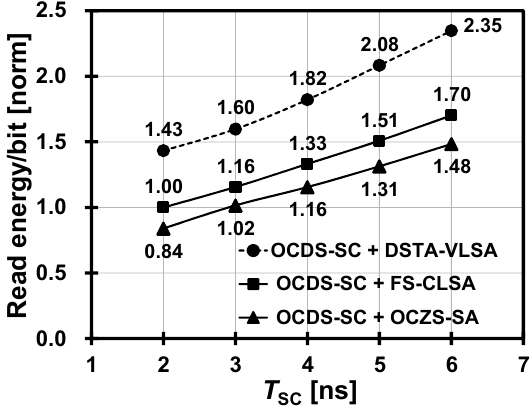
Figure 12. Minimum I read of the OCDS-SC that satisfies a target RAPY CELL of 6 σ according to T SC at σ SA_OS values of 33.8 mV, 20 mV, and 9.62 mV.